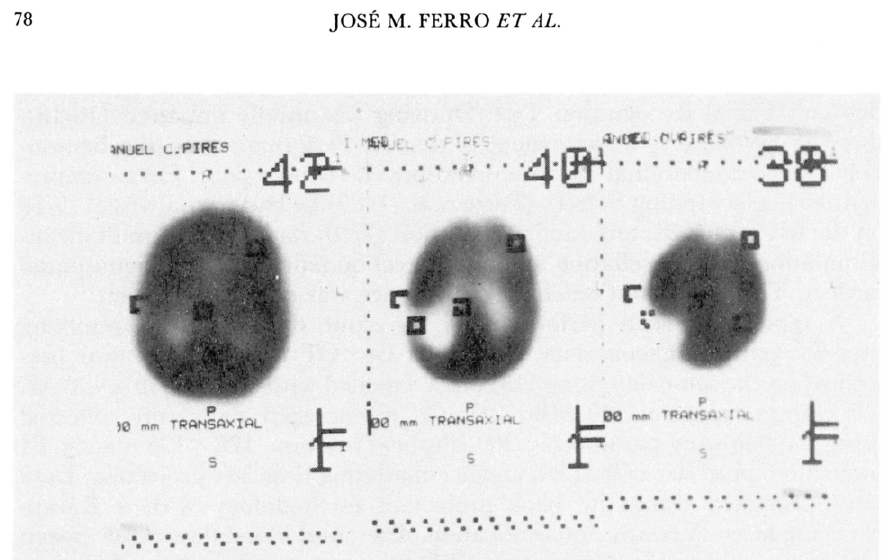
FIG. 2. 99"· HMPAO SPECT: three consecutive transaxial slices demonstrating focal hypoperfusion on the right temporo parietal